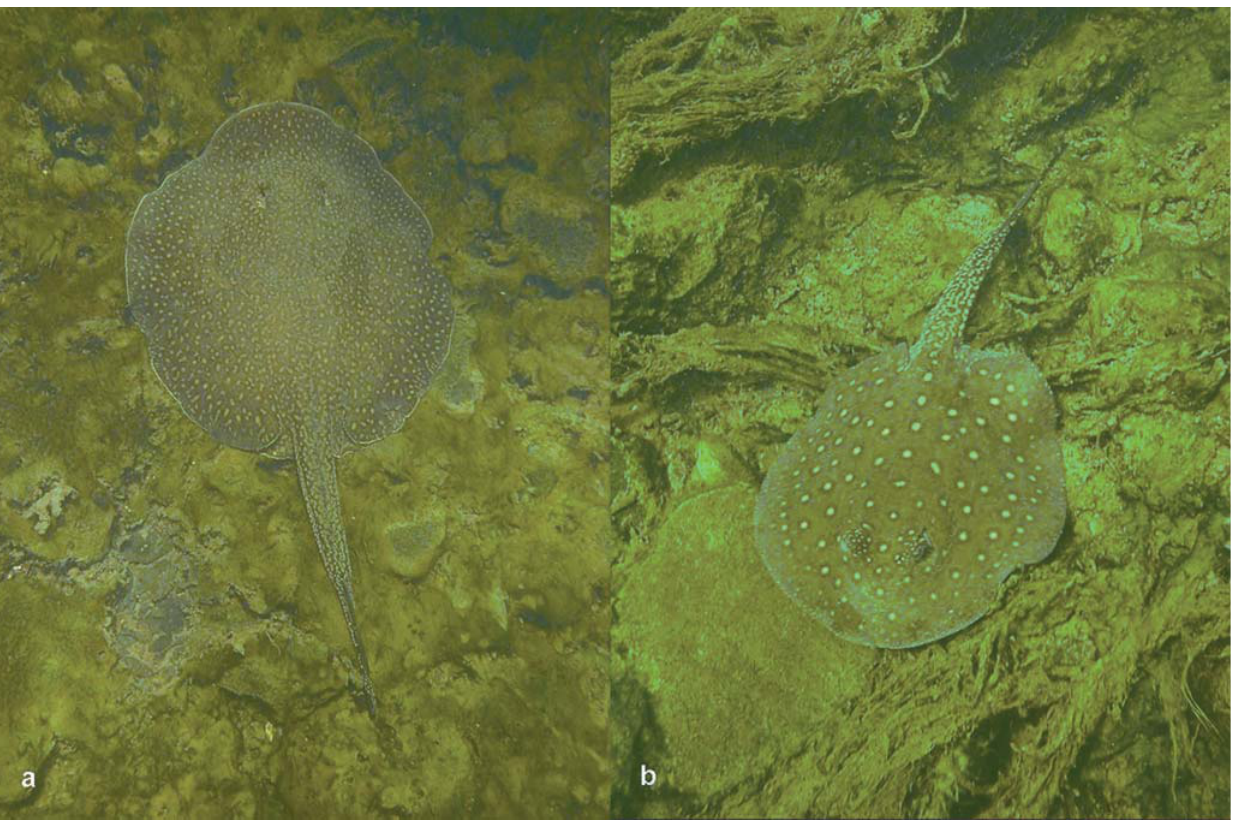
Fig. 2. Potamotrygon falkneri Castex & Maciel, 1963 (female; DW = 43 cm) ( a ), and P. motoro (Müller & Henle, 1841) (male; DW = 32 cm) ( b